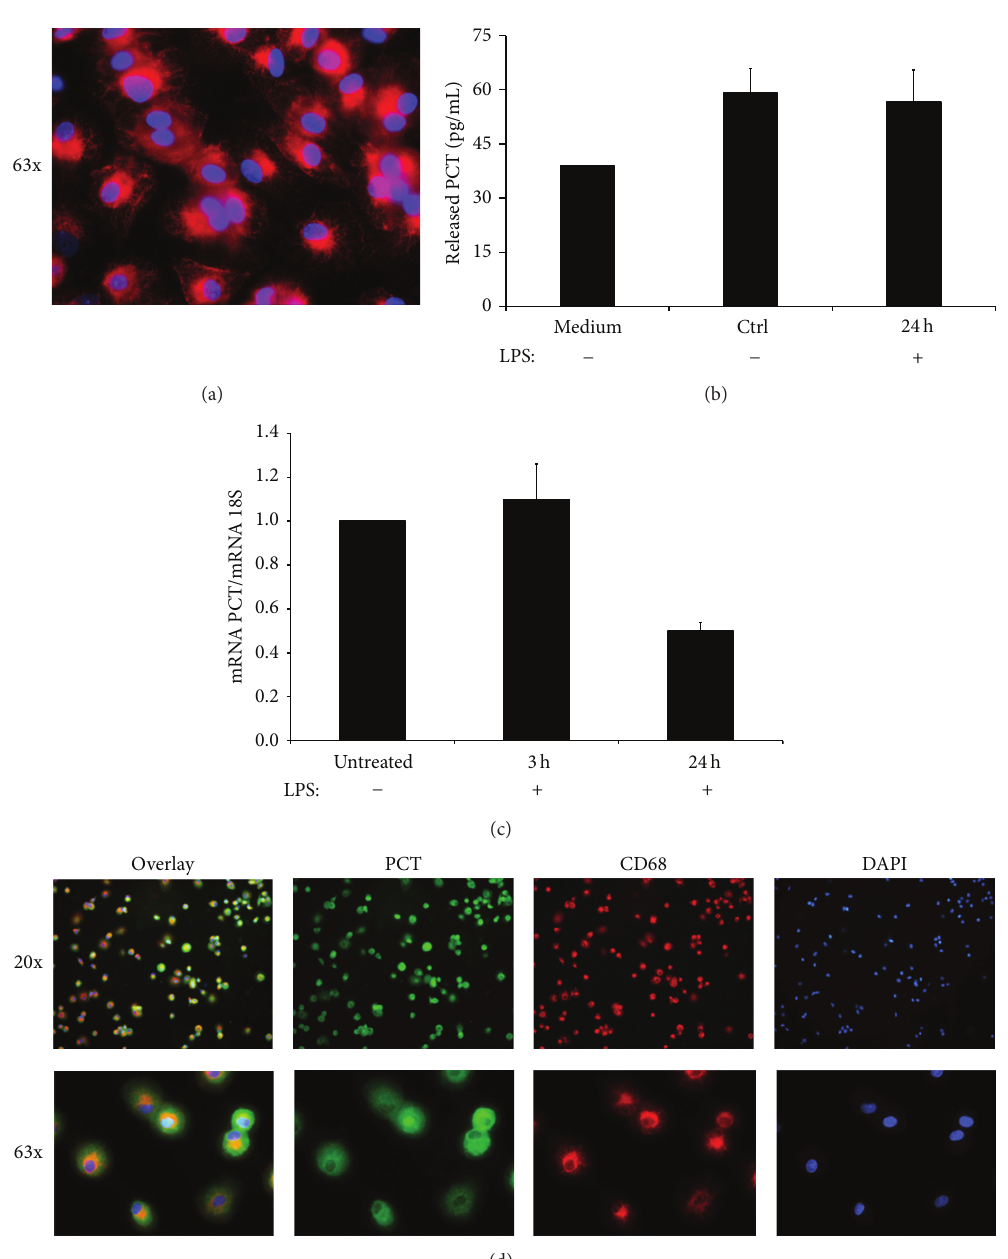
Figure 1: Human macrophages express PCT at mRNA and protein level. (a) Immunofluorescence analysis of human macrophages differentiated from PBMCs. Cells were stained with mAb anti-human CD68. DAPI nuclear staining is shown in blue. Original magnification 63x. (b) Levels of PCT secreted in the cell supernatant by cultured macrophages after 24 hours of stimulation with LPS. Data from 5